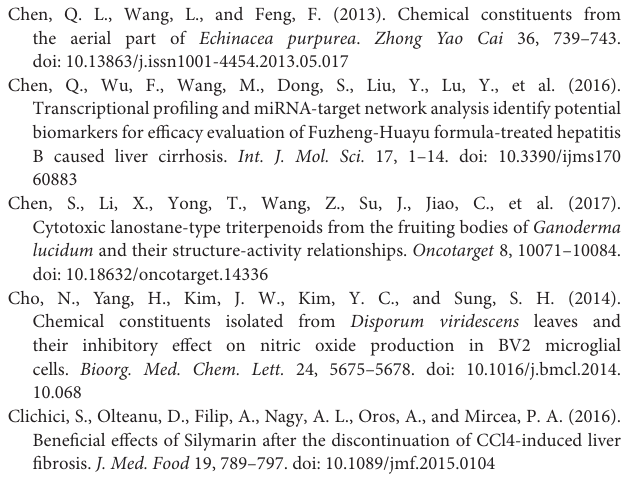
Supplementary Figure 6 | GO classification of all identified proteins, all altered proteins, up-regulated altered proteins and down-regulated altered proteins between H-ZYCH and DMN-model groups in molecular function. Union of The first 15 subtypes of all identified proteins and all altered proteins in GO classification were analyzed. Supplementary Figure 7 | GO classification of all identified proteins, all altered proteins, up-regulated altered p6roteins and down-regulated altered proteins between H-ZYCH and DMN-model groups in biological process. Union of The first 15 subtypes of all identified proteins and all altered proteins in GO classification were analyzed. Supplementary Figure 8 | ELISA analysis for proteomics validation of H-ZYCH and DMN-model rats in liver tissues. (A) The activity of SOD; (B) the production of MDA; (C) the production of α -SMA; (D) the production of COLIV. # p < 0.05, ## p < 0.01 vs. control group, ∗ p < 0.05, ∗∗ p < 0.01 vs. model group. Supplementary Table 1 | The experimental schedule of ZYCH anti-liver fibrosis induced by DMN. Supplementary Table 2 | The molecular docking results of ZYCH anti-liver fibrosis protein